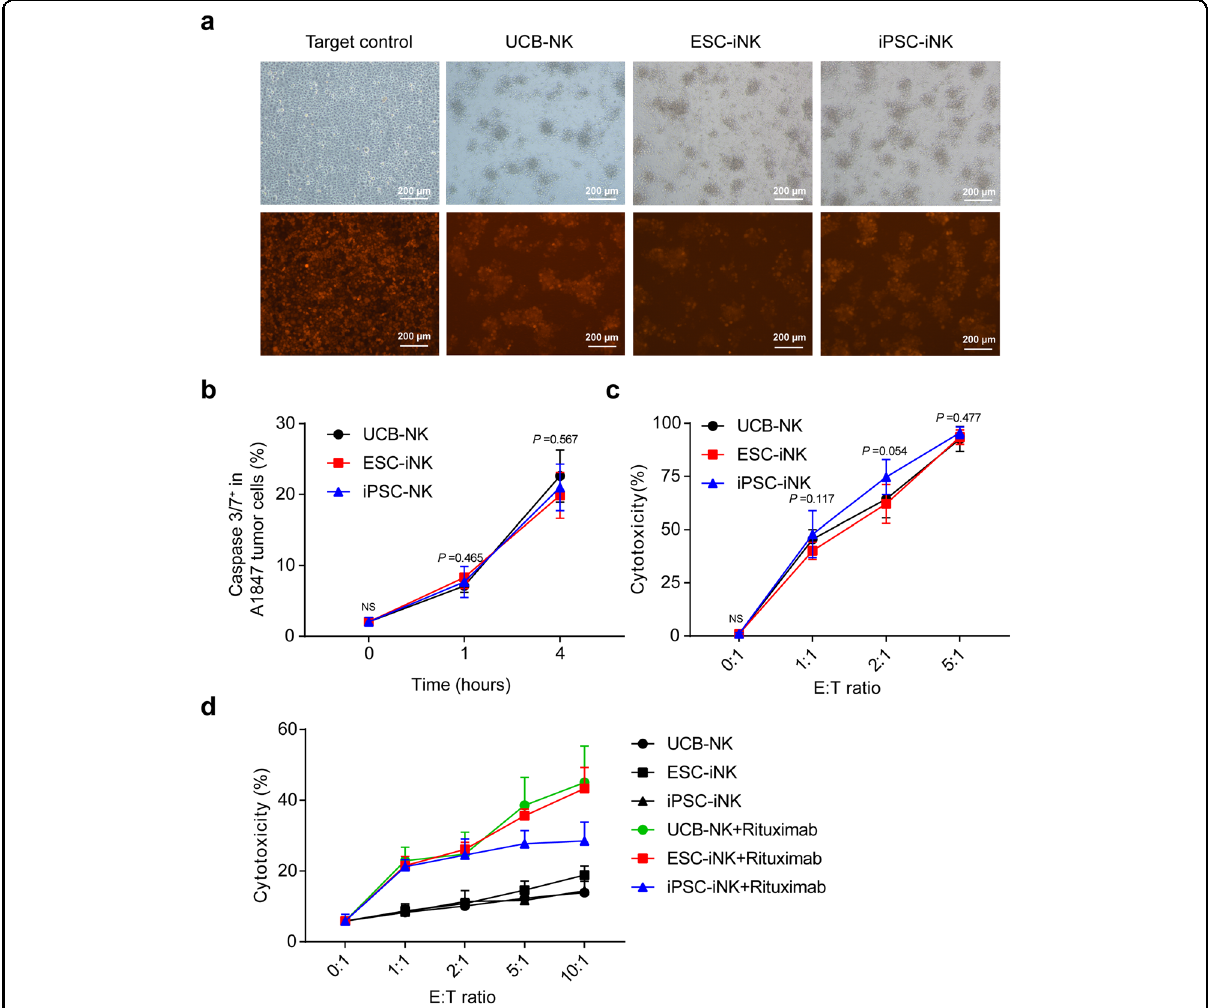
Fig. 4 iNK cells exhibit tumor-killing activities in vitro. a Representative images of residual A1847-tdTomato + tumor cells (Target, T) after 4-h co- culture with iNK cells (Effector, E) (E:T = 5:1). b Flow cytometry analysis of apoptotic A1847-tdTomato + tumor cells post co-culture with iNK cells (E:T = 2:1) for 1 h and 4 h. n = 6 each group. c Cytotoxicity analysis of the iNK cells. iNK cells were co-cultured with CFSE-labeled A1847 tumor cells for 4 h at the indicated effector to target ratios. n = 6 each group. d ADCC analysis of iNK cells. iNK cells were co-cultured with CFSE-labeled Raji cells in the presence of anti-CD20 antibody (Rituximab, 20 μ g/mL) for 4 h at the indicated effector to target ratios. n = 9 each group. Data were collected from two ( b , c ) or three ( d ) independent experiments. One-way ANOVA and Kruskal-Wallis tests were used for statistics. NS, not signi fi cant. ESC: human ESC line hPSC-2; iPSC: human iPSC line